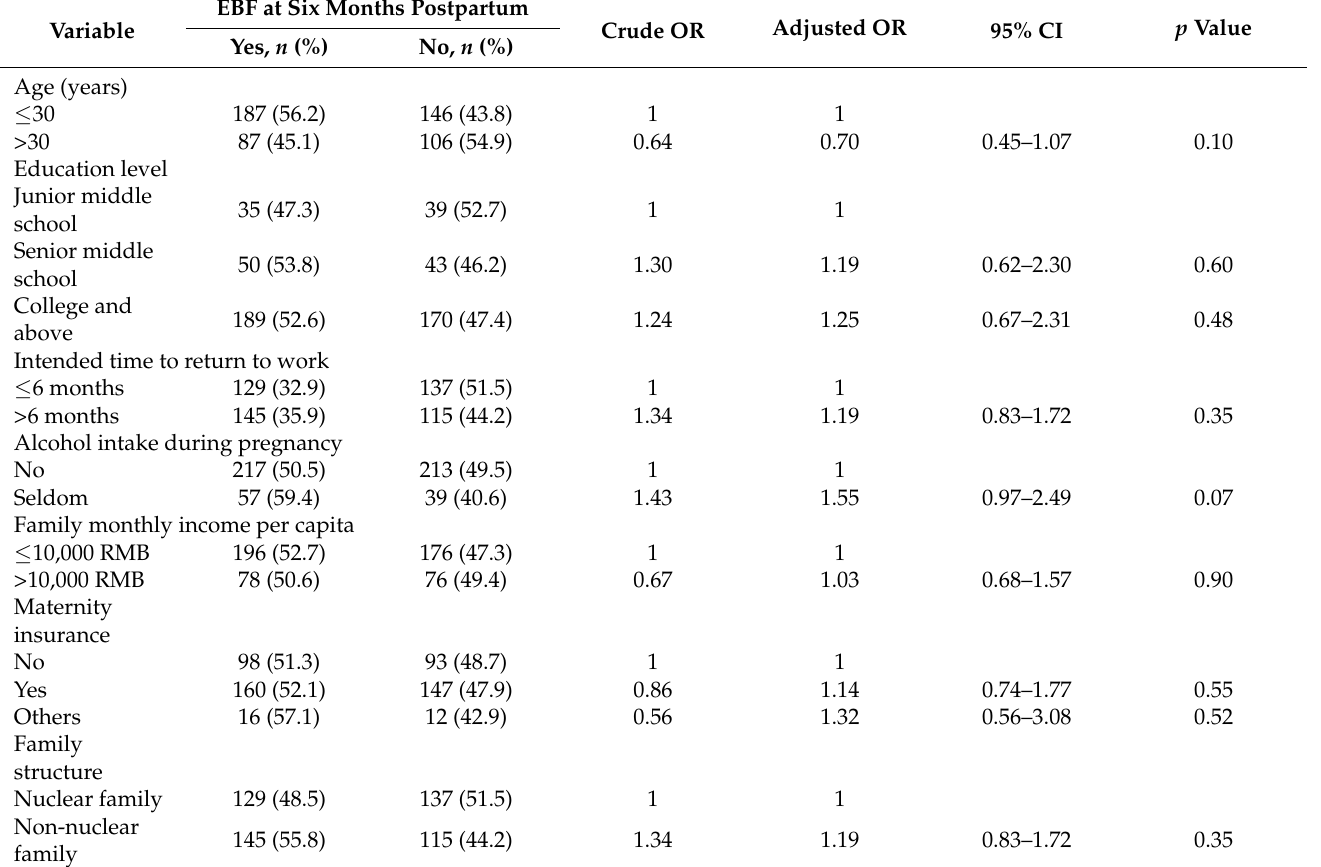
Table 3. Associations between in-hospital BF supportive service and exclusive breastfeeding (EBF) at six months postpartum ( n =